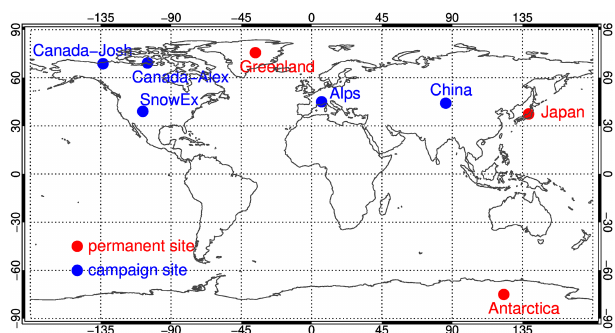
Figure 1. Geographic distribution of the validation sites. The colors represent the type of each site, and the site name used in this paper is indicated near each